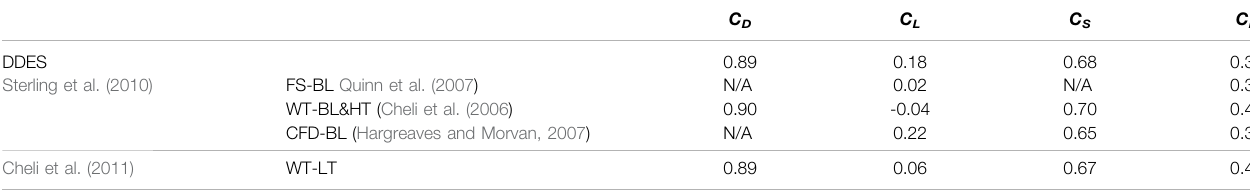
TABLE 1 | List of the aerodynamic coef fi cients obtained from the current work and literature of the similar lorry shape.